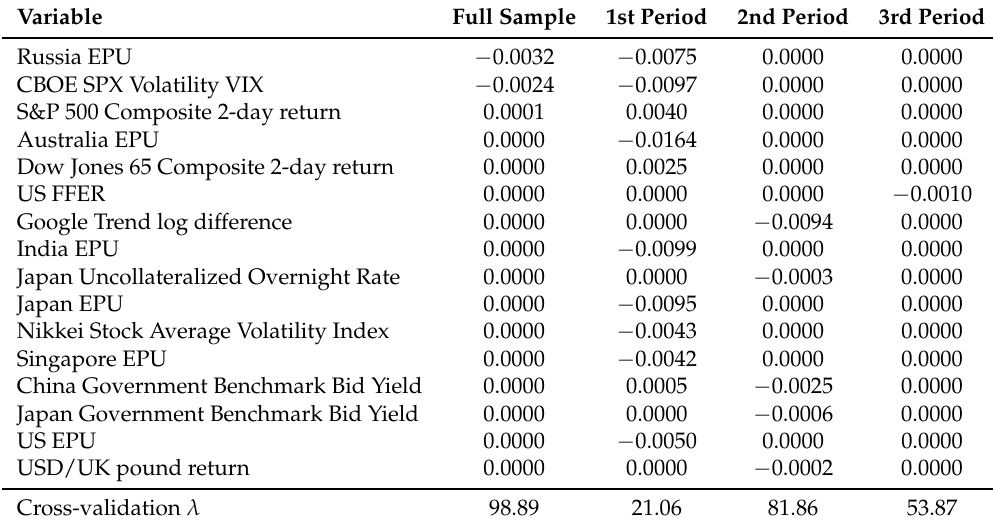
Table 3. PC-LASSO with geographic region components coefficients of independent